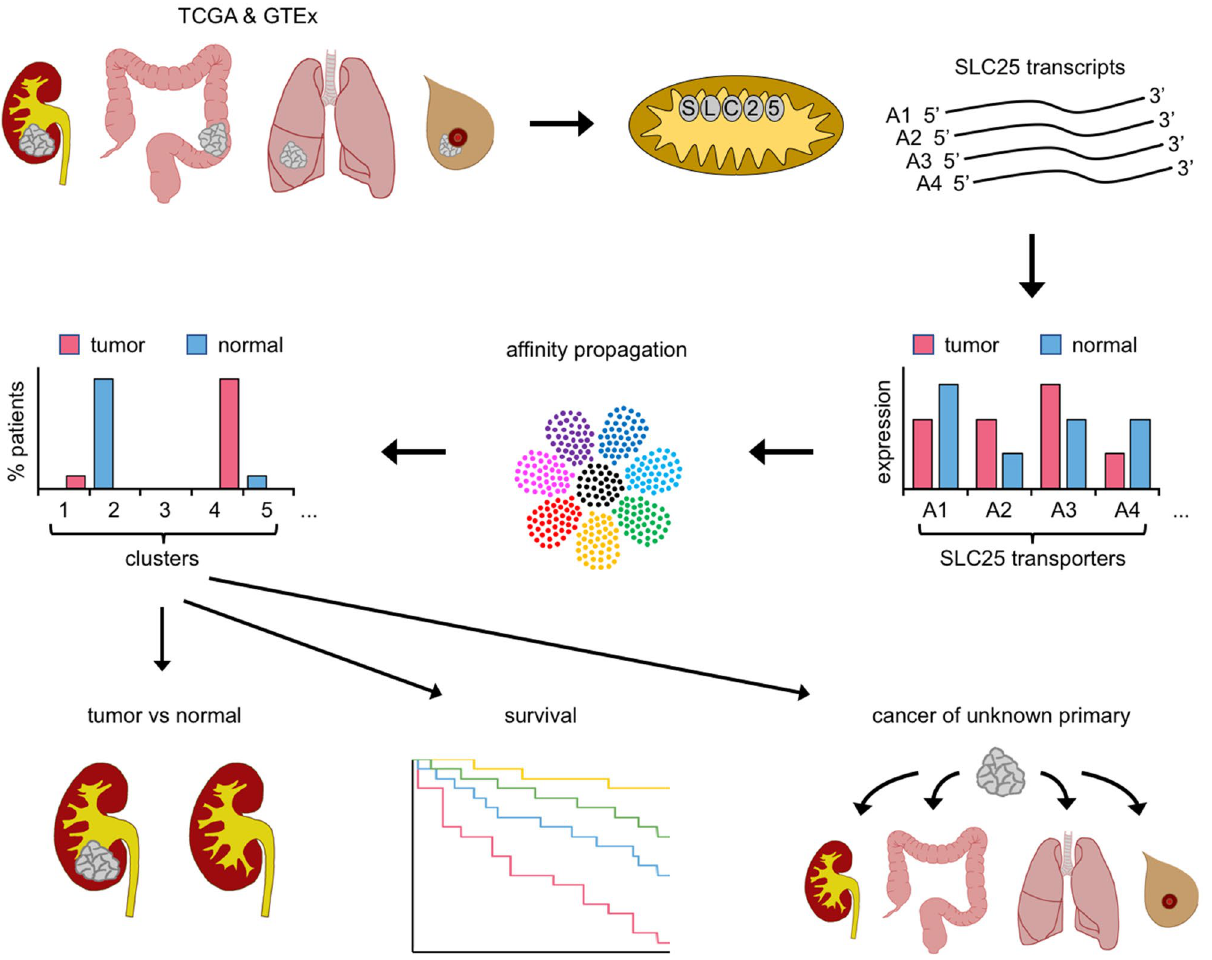
Figure 6. Diagrammatic presentation of the mitochondrial SLC25 transporter algorithm used to identify and characterize human cancer types and